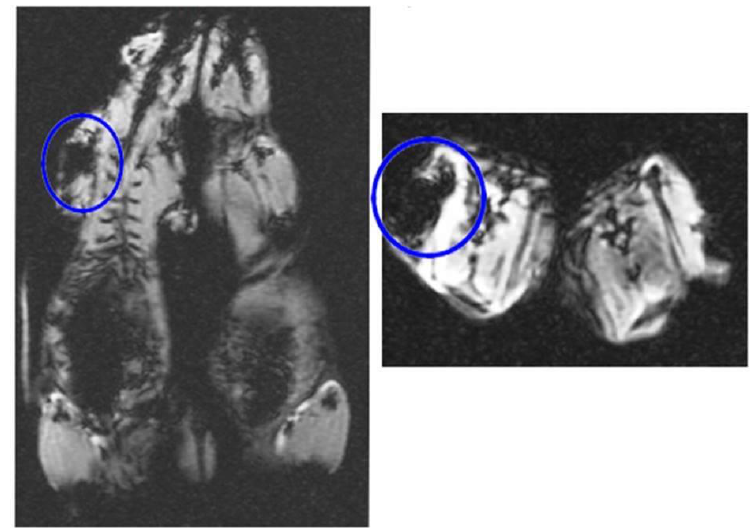
Figure 5. The T2* weighted images of in vivo samples showing the hypo-intense signal of 180 µg/mL of iron oxide labeled DPSCs transfected with 1 µL/mL lipofectamine that confirms presence of iron oxide in the labeled cells in comparison to in vivo samples of non-labeled cells showing lack of this MRI appearance (Left and Right).